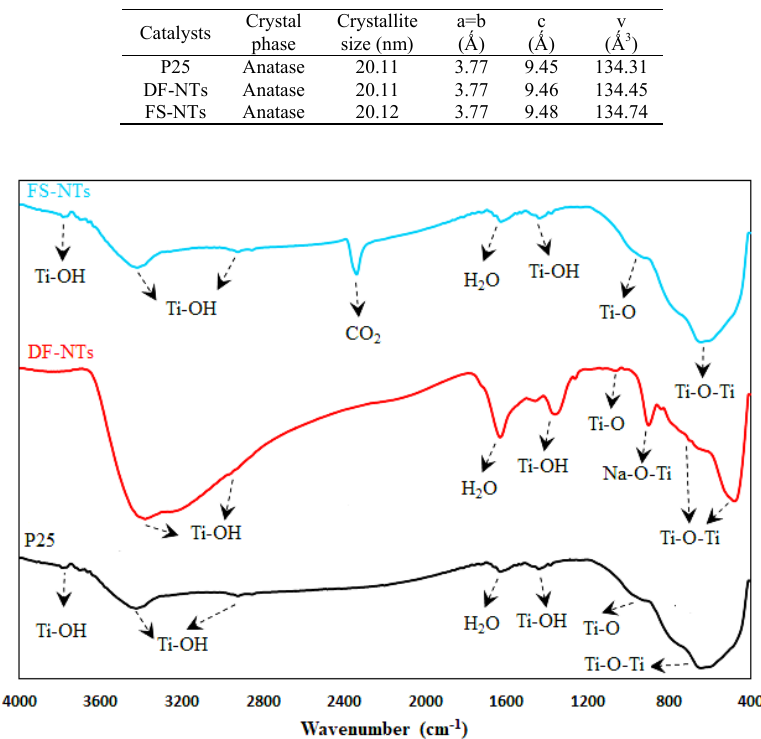
Fig. 4. FTIR spectra corresponding to DF-NTs and